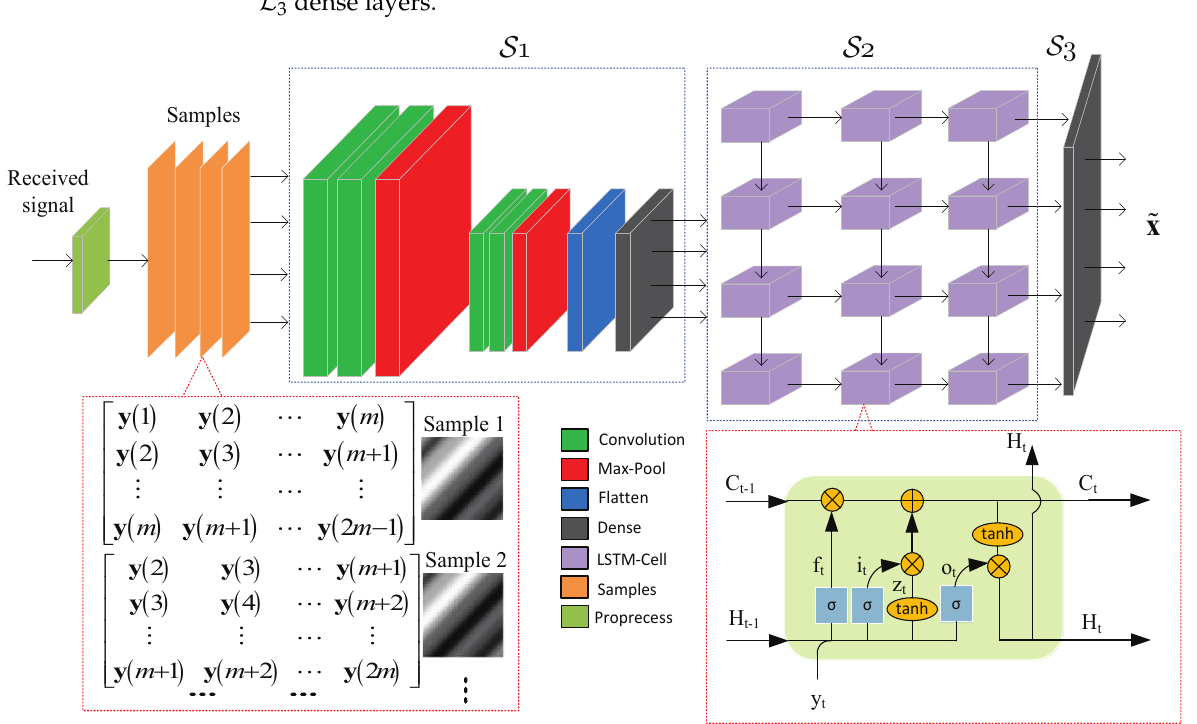
Figure 2. Schematic of the proposed DL scheme with the Volterra spatial feature. The samples Y ∈ R ( N − 2 m + 2 ) × m × m are then fed into S 1 for feature extraction. The